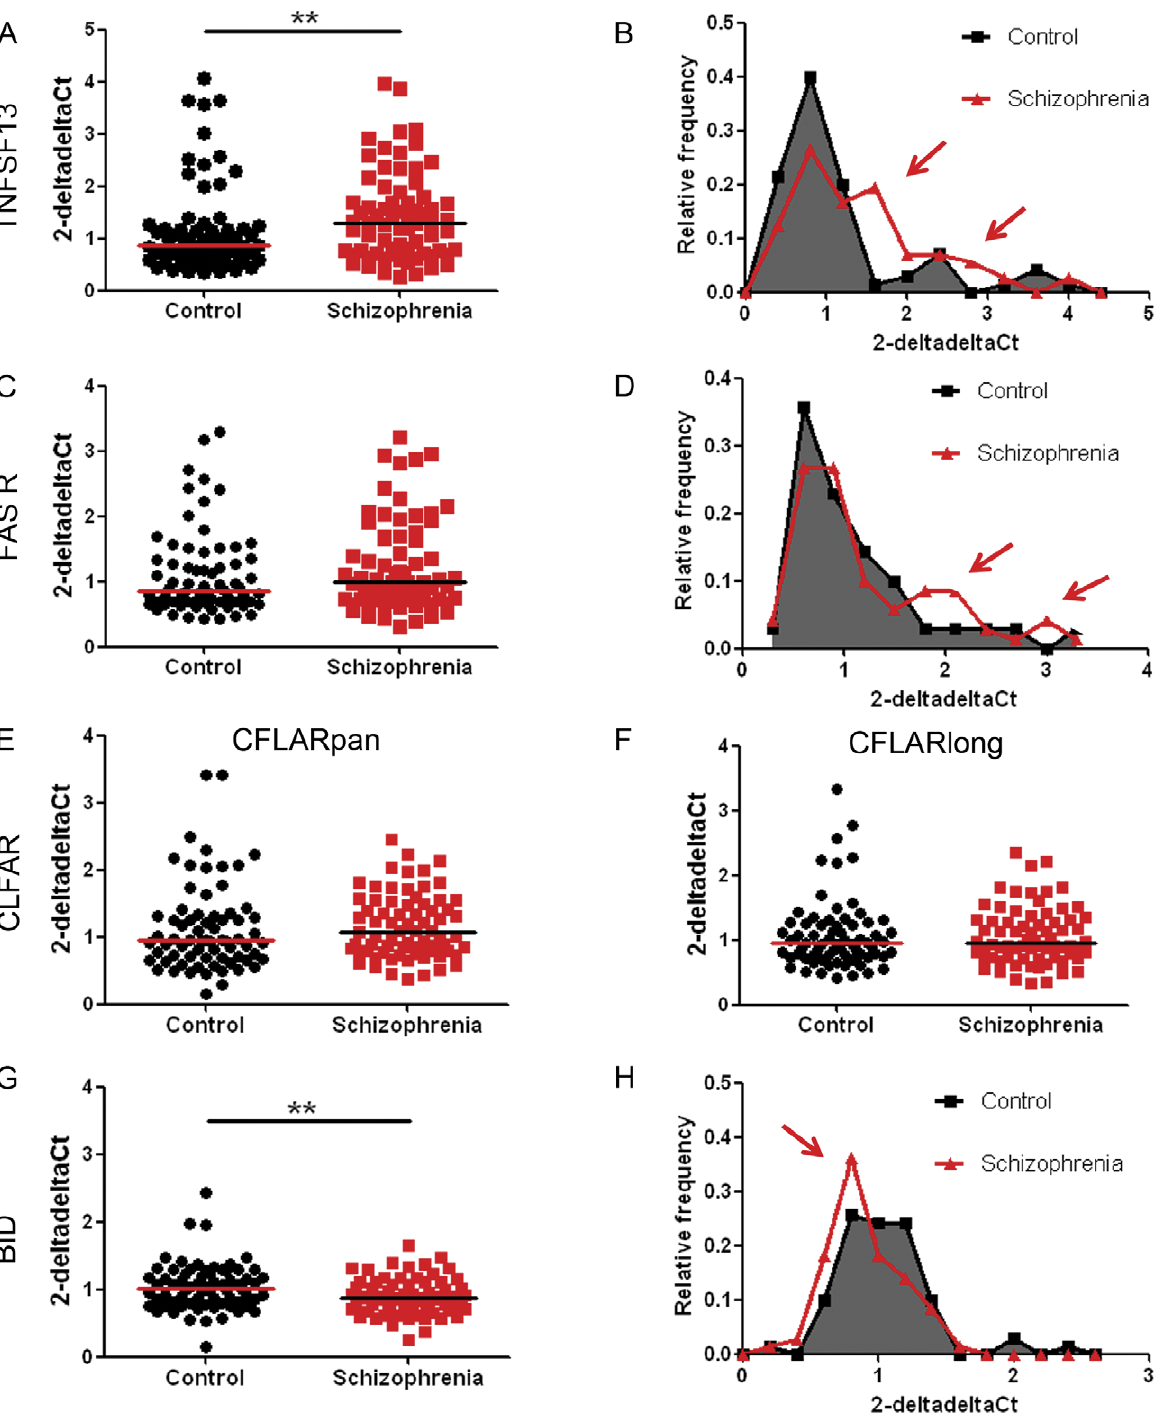
Figure 2. Gene expression levels of TNFSF13-FAS receptor pathway genes of interest relative to three housekeeping genes in dorsolateral prefrontal cortex from patients with schizophrenia. cDNA samples obtained from the combined SMRI and NSW TRC collections from individuals with schizophrenia and unaffected controls were subjected to qRT-PCR. Expressions of TNFSF13 (A), FAS receptor (C), CFLAR pan (E), CFLAR long (F) and BID (G) relative to three housekeeping genes ( b -actin, TATA box binding protein and ubiquitin C) were calculated using the deltadelta Ct method. Horizontal lines indicate the population median, except for panel (G) where they indicate the mean as those data were normally distributed. Frequency distributions for TNFSF13, FAS receptor and BID are displayed in panels (B), (D), and (H). ** p , 0.01.